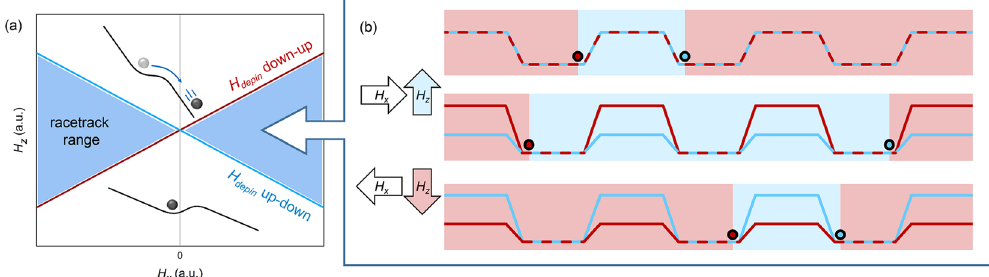
Figure 1. Device concept. ( a ) Schematic graph of the change in H depin (both for up-down and down-up domain walls) as a function of H x . If H z is below H depin a DW stays pinned at an anisotropy barrier while above H depin it will move past it, as indicated by the black inset cartoons. ( b ) An initial magnetic configuration is shown in the top cartoon (red shading = down, blue shading = up) together with a schematic energy landscape for the domain walls, which are represented by circles. H x lowers the energy barriers for one type of DW, which is subsequently moved by an H z pulse, and the system ends up in the configuration shown in the middle cartoon. A following H x and H z with opposite sign move the other type of DWs in the same direction, ending up in the configuration shown in the bottom